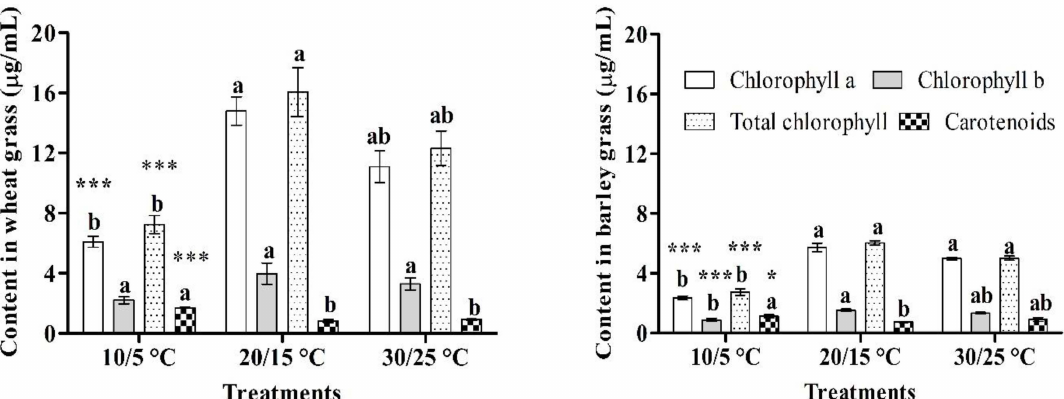
Figure 1. Chlorophyll and carotenoid contents of wheat and barley grass extracts treated at different day and night temperatures. Mean values were analyzed by Tukey test ( n = 5 ± standard error). NS, *, ***; not significant, and significant at p ≤ 0.05 and 0.001, respectively. Values with the same letters in a treatment are not significantly different by Tukey